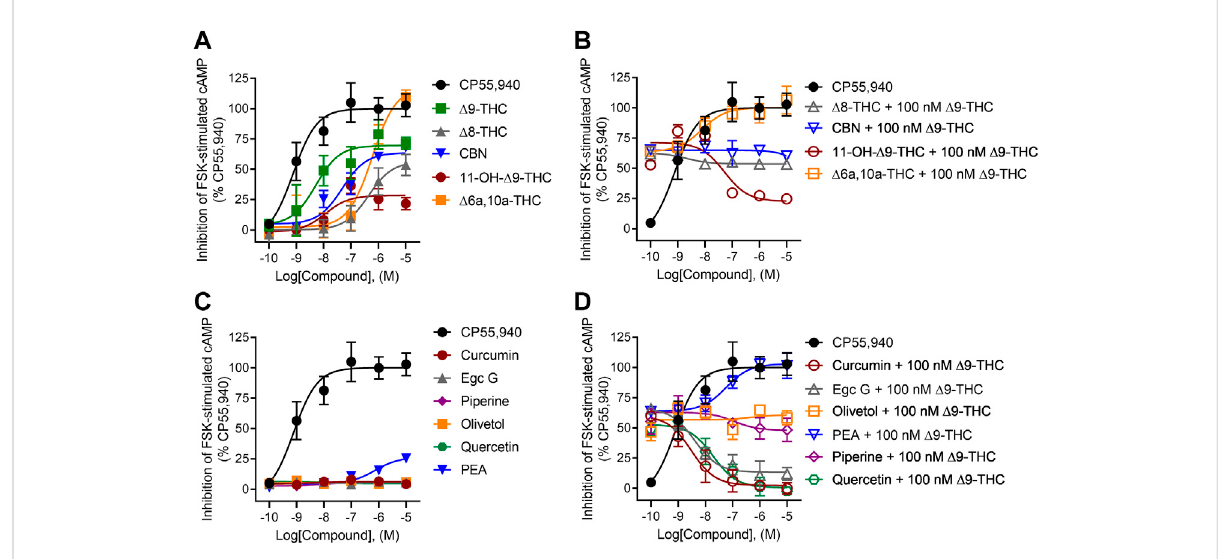
FIGURE 3 hCB1R-dependent inhibition of forskolin-stimulated cAMP accumulation. Compound activity was quanti fi ed for inhibition of 10 µM forskolin- stimulated cAMP accumulation in CHO cells stably expressing hCB1R and treated with 0.1 nM — 10 µM (A) cannabinoids; (B) cannabinoids + 100 nM Δ 9 -THC; (C) phytomolecules; and (D) phytomolecules + 100 nM Δ 9 -THC for 90 min according to the standard operating procedures of the HitHunter assay. Data were fi t to a variable slope (four parameters) non-linear regression in GraphPad (v. 9). n ≥ 6 independent experiments were performed in triplicate. Data are expressed as mean ± SEM. EC 50 and E max are reported in Table